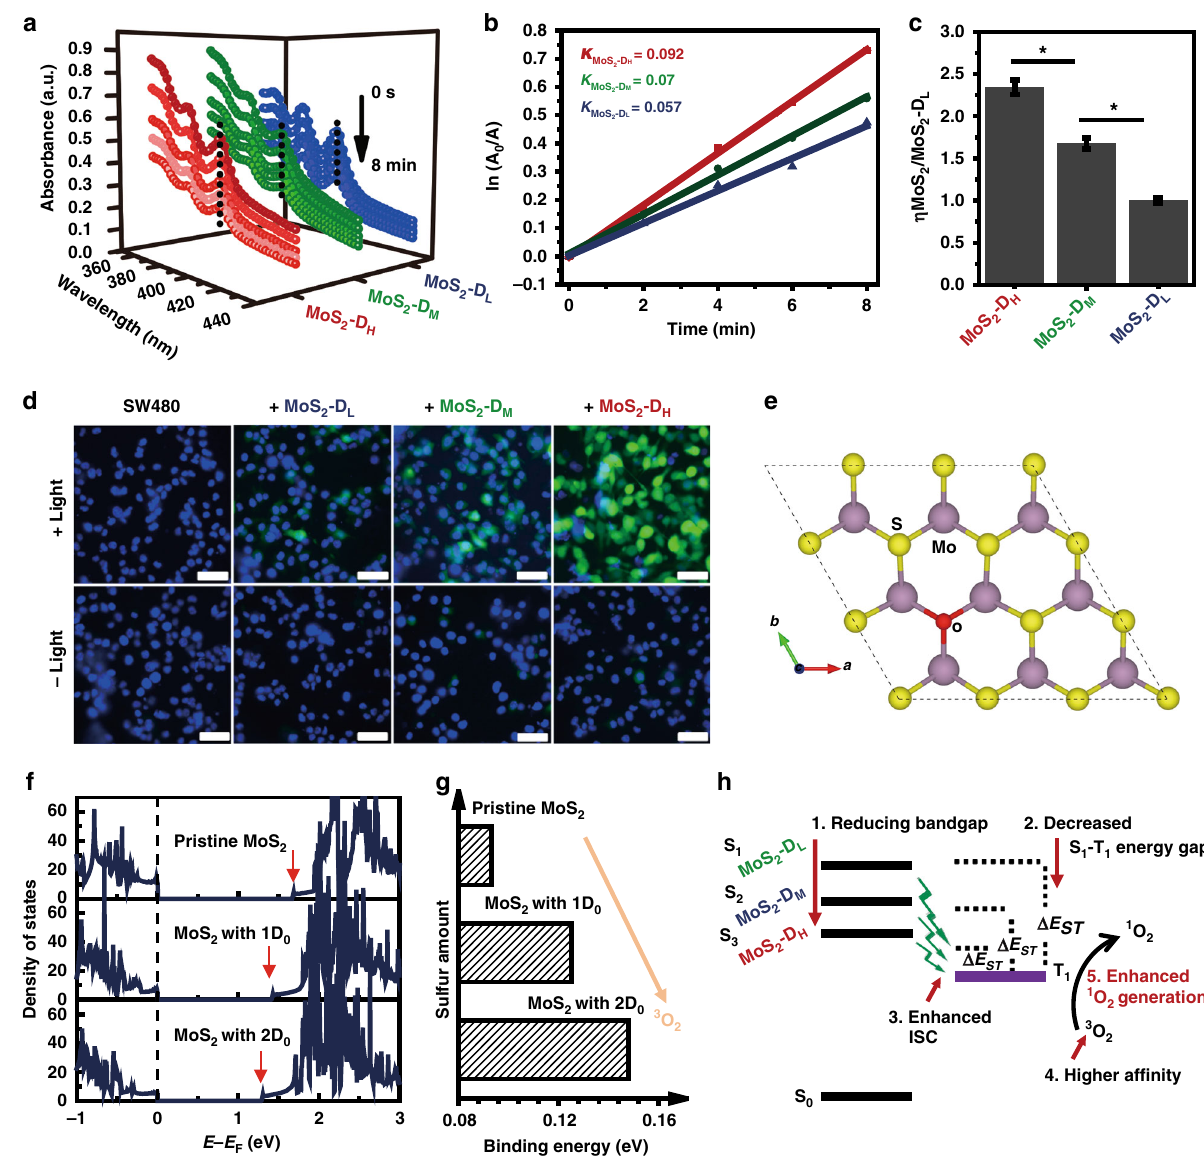
Fig. 6 Positive correlation between sulfur defects and photodynamic ef fi ciency in QDs. a Absorption spectra of three kinds of MoS 2 QDs in the presence of ABDA under light irradiation (0.1 W cm-2, 8 min). b Typical decomposition rate of the photosensitizing process, where A 0 is the absorbance of initial absorbance of ABDA and A is the absorbance of ABDA under light irradiation at different time points (Full data plots can be found as Supplementary Figure 19). c Relative 1 O 2 quantum yield of two MoS 2 QDs groups relative to MoS 2 -D L QDs. Mean ± SD, n = 4, Student ’ s t -test, p * < 0.05. d Detection of ROS generation at cellular level in colon cancer cell line, SW480 by intracellular ROS indicator H 2 DCFH-DA. Scale bar: 50 μ m. e Structure illustration for the substitution of oxygen for sulfur within MoS 2 lattices. f Calculated density of states of MoS 2 QDs show the defects reduce the bandgap. g More sulfur defects induce stronger binding af fi nity of 3 O 2 to MoS 2 . h Proposed defect related 1 O 2 generation mechanism of MoS 2